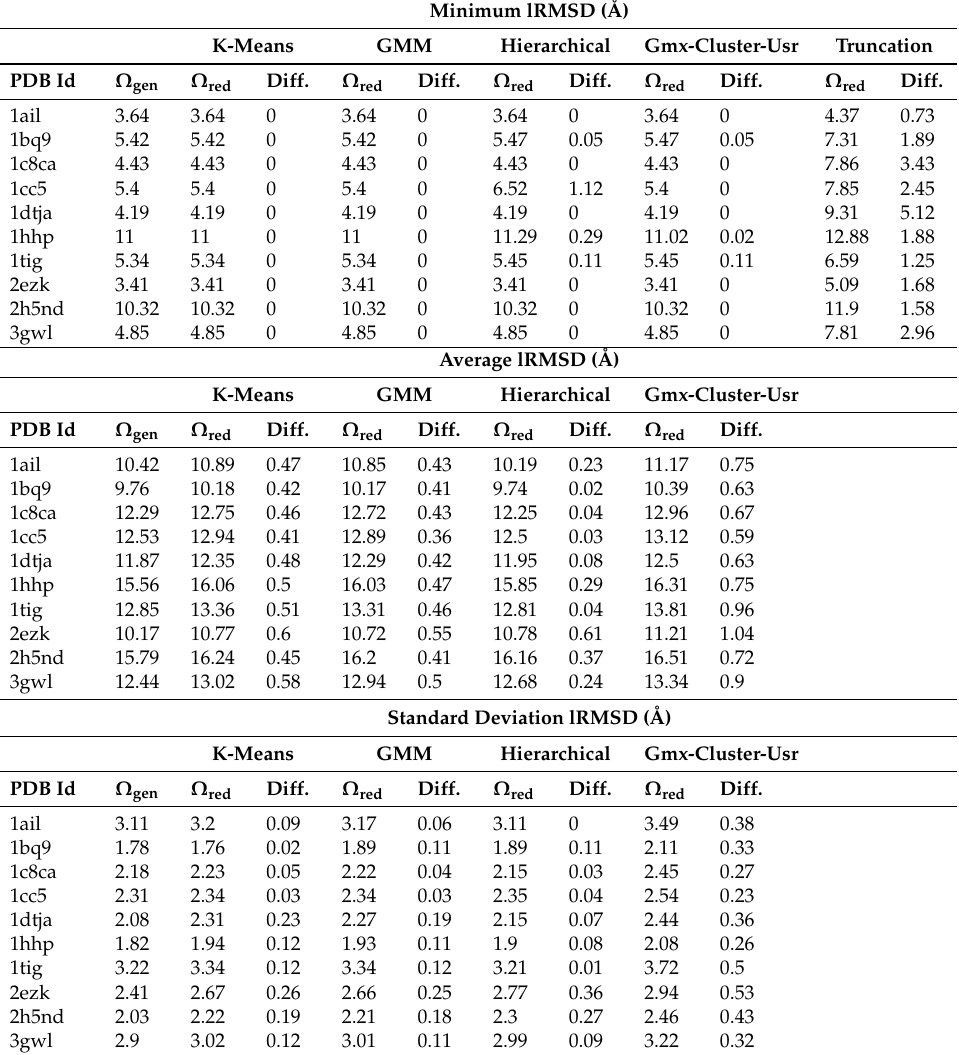
Table 3. Comparison of minimum, average, and standard deviation of lRMSDs (to the known native structure) of structures in the Ω gen and Ω red ensembles of each target in the benchmark dataset. Comparison of minimum lRMSDs includes the ensemble reduced via truncation selection. Differences between the minimum, average, and standard deviation obtained over Ω red from those obtained over Ω gen are also